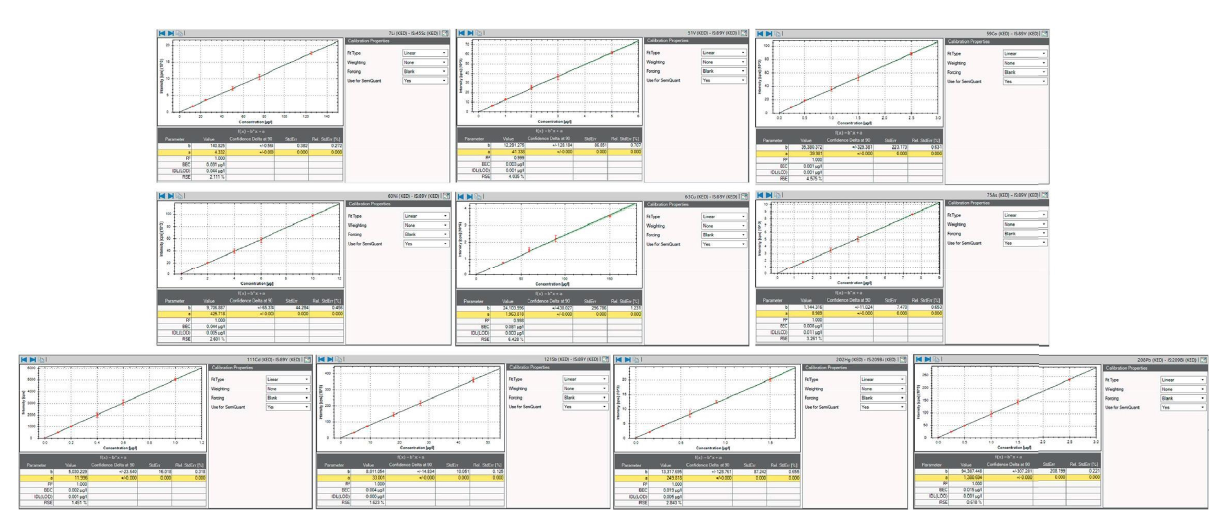
Figure 2: Linearity calibration plots of elements Li, V Co, Cu, As, Cd, Sb, Hg, and Pb.